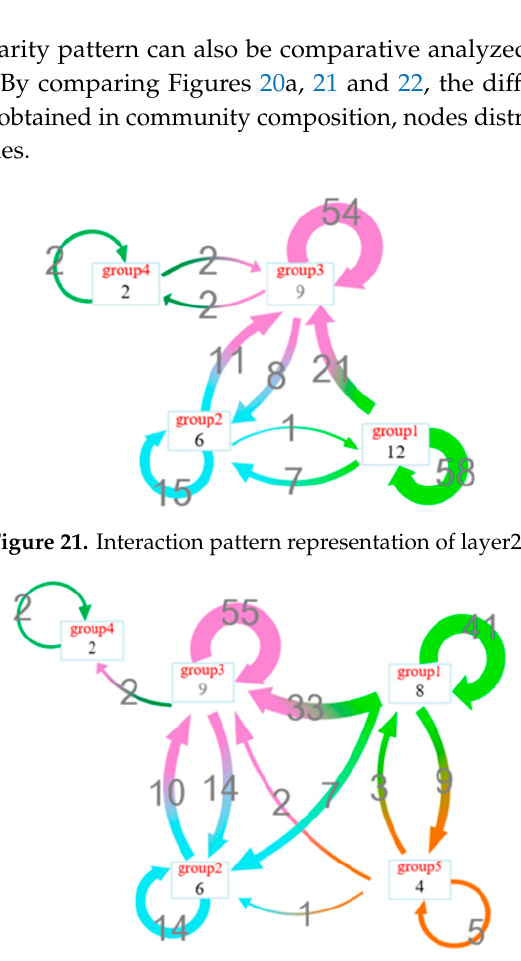
Figure 22. Interaction pattern representation of layer3.